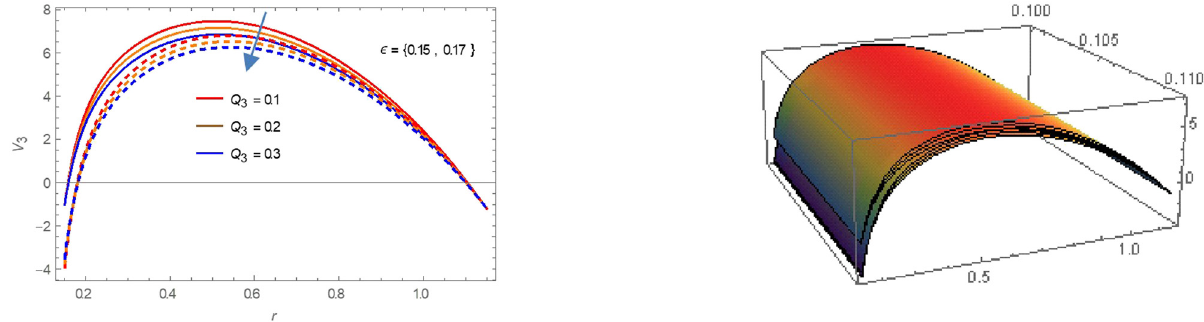
Figure 4: Distribution of velocity for di ff erent values of ϵ and Q 3 with W